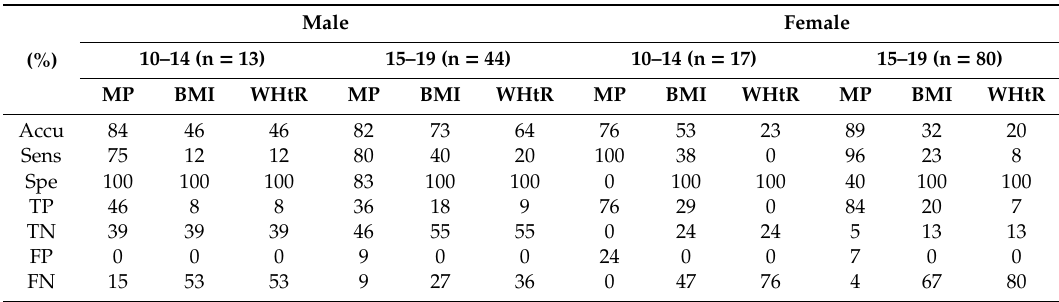
Table 5. Analysis of the performance of the proposed methods in the data set relative to the anthropometric indicators BMI and WHtR, stratified by gender and